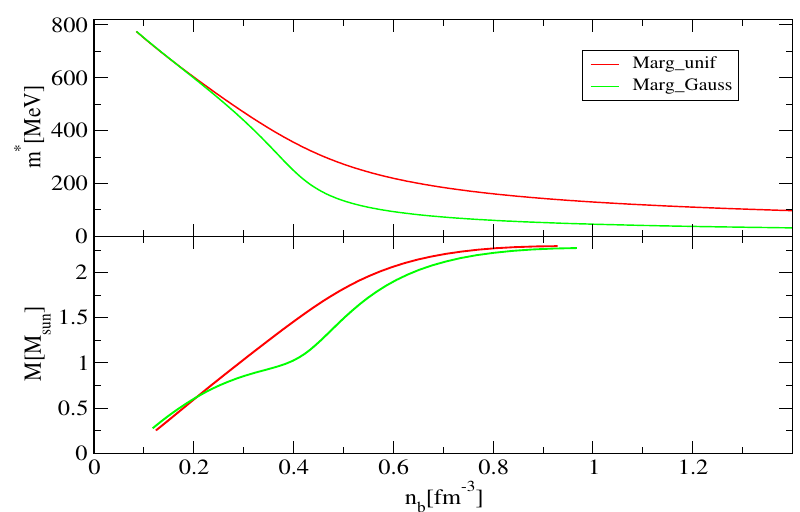
Figure 3. Upper panel: m ∗ as a function of the density for the most probable EoSs obtained with the two priors here adopted. Lower panel: for the same EoSs, we display the relation between the mass of the star and its central density